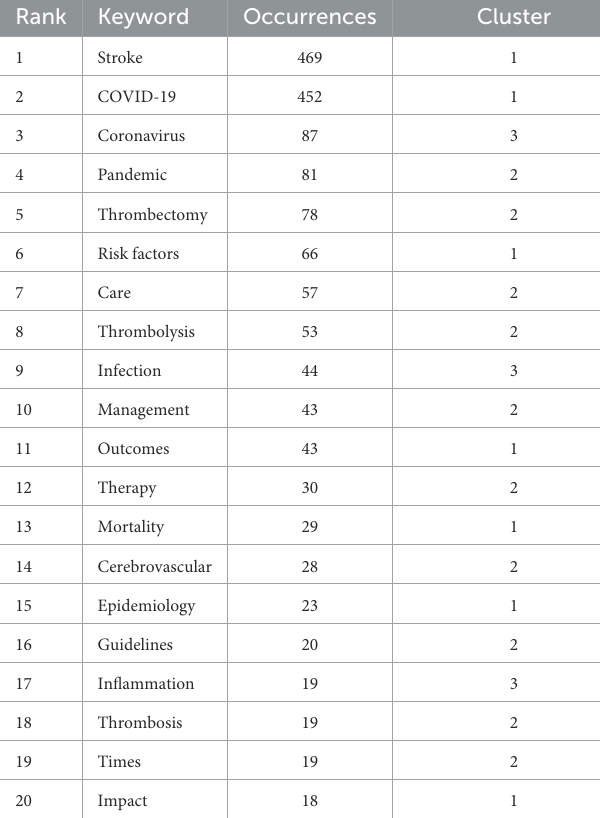
TABLE 6 Top 20 most frequent